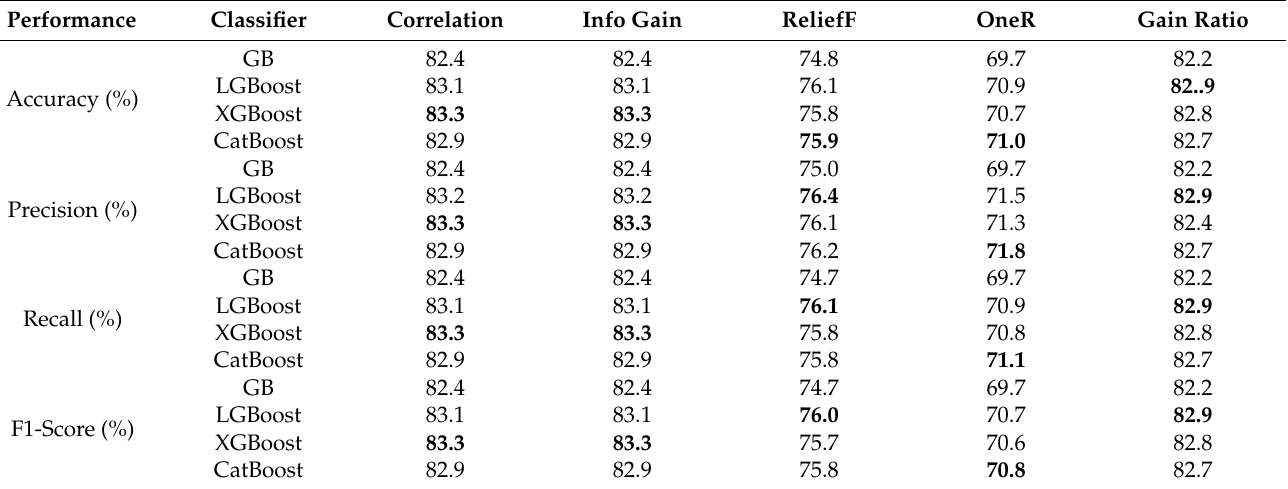
Table 9. Results of the models with respect to SMOTE and feature selection